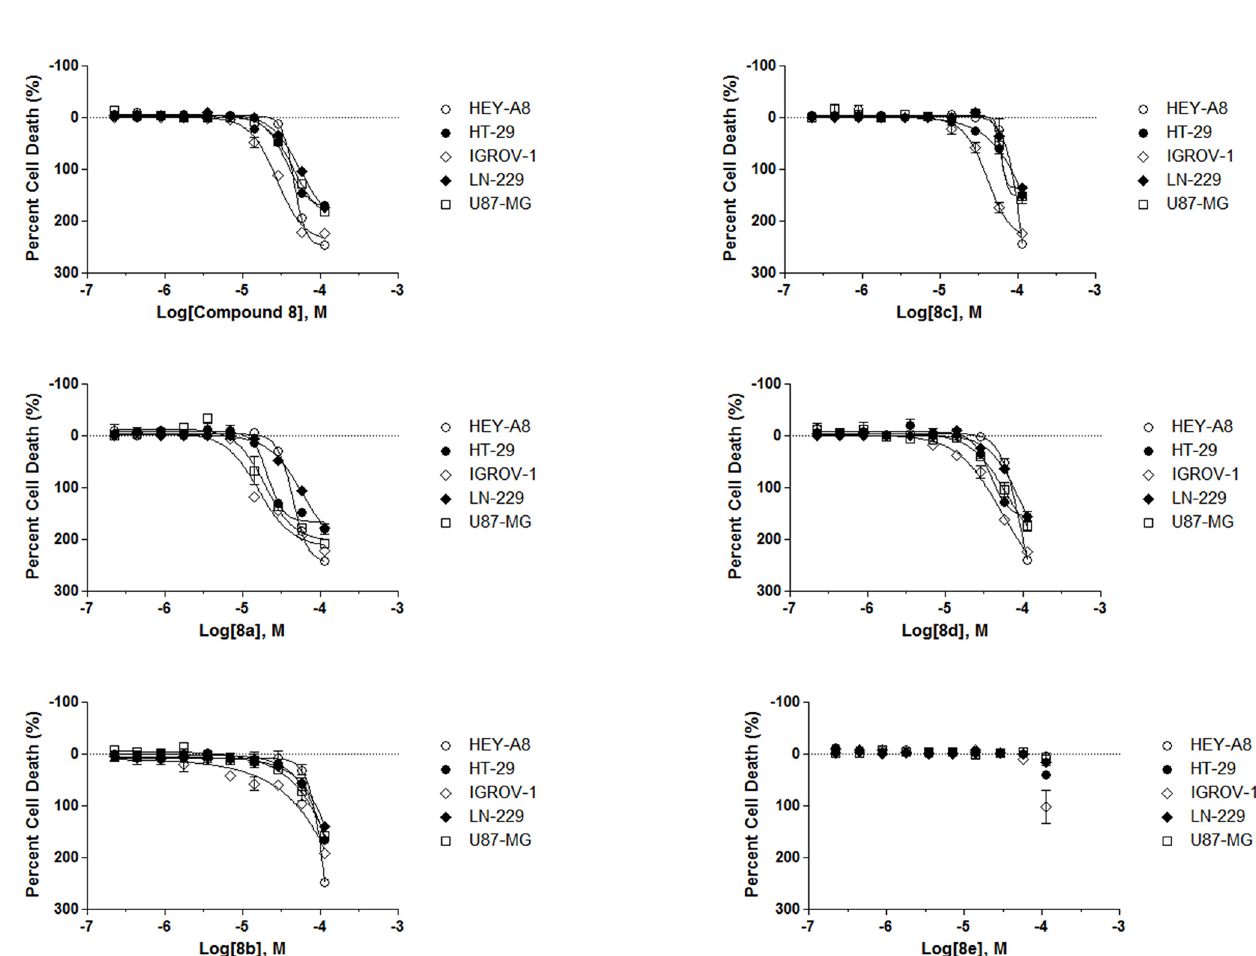
Fig 7. Compound 8 analogs reduce the viability of cancer cell lines. CellTiter-Glo viability assay of glioma (U87-MG and LN-229), ovarian (IGROV-1 and HEY-A8) and colon (HT-29) cancer cell lines treated for 48 h with compound 8